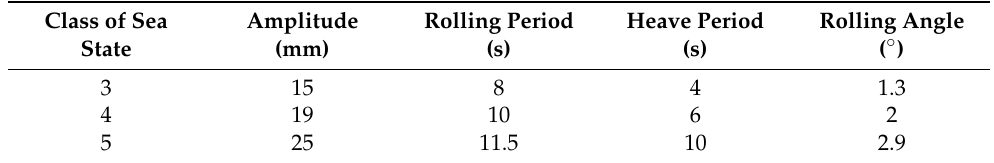
Table 1. Simulation parameters of a six-degrees-of-freedom moving platform under different sea conditions.